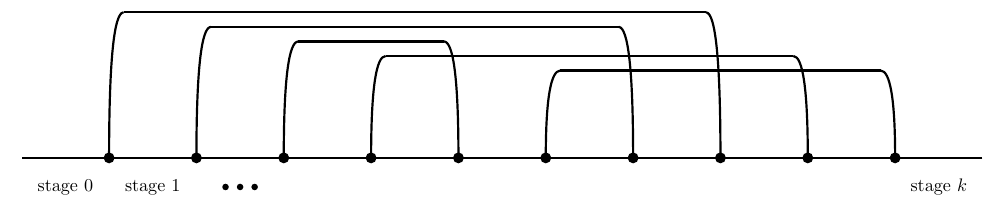
Figure 3. Cutting open a chord